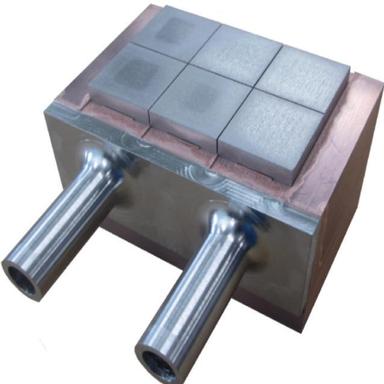
Photograph of the first AMSB divertor mock-up.